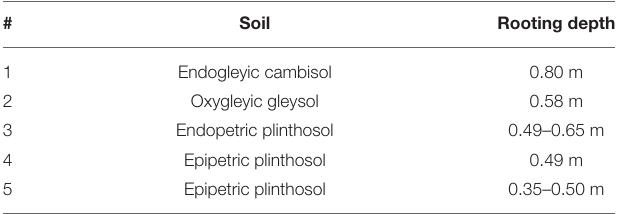
TABLE 3 | Soil type and rooting depth of soil